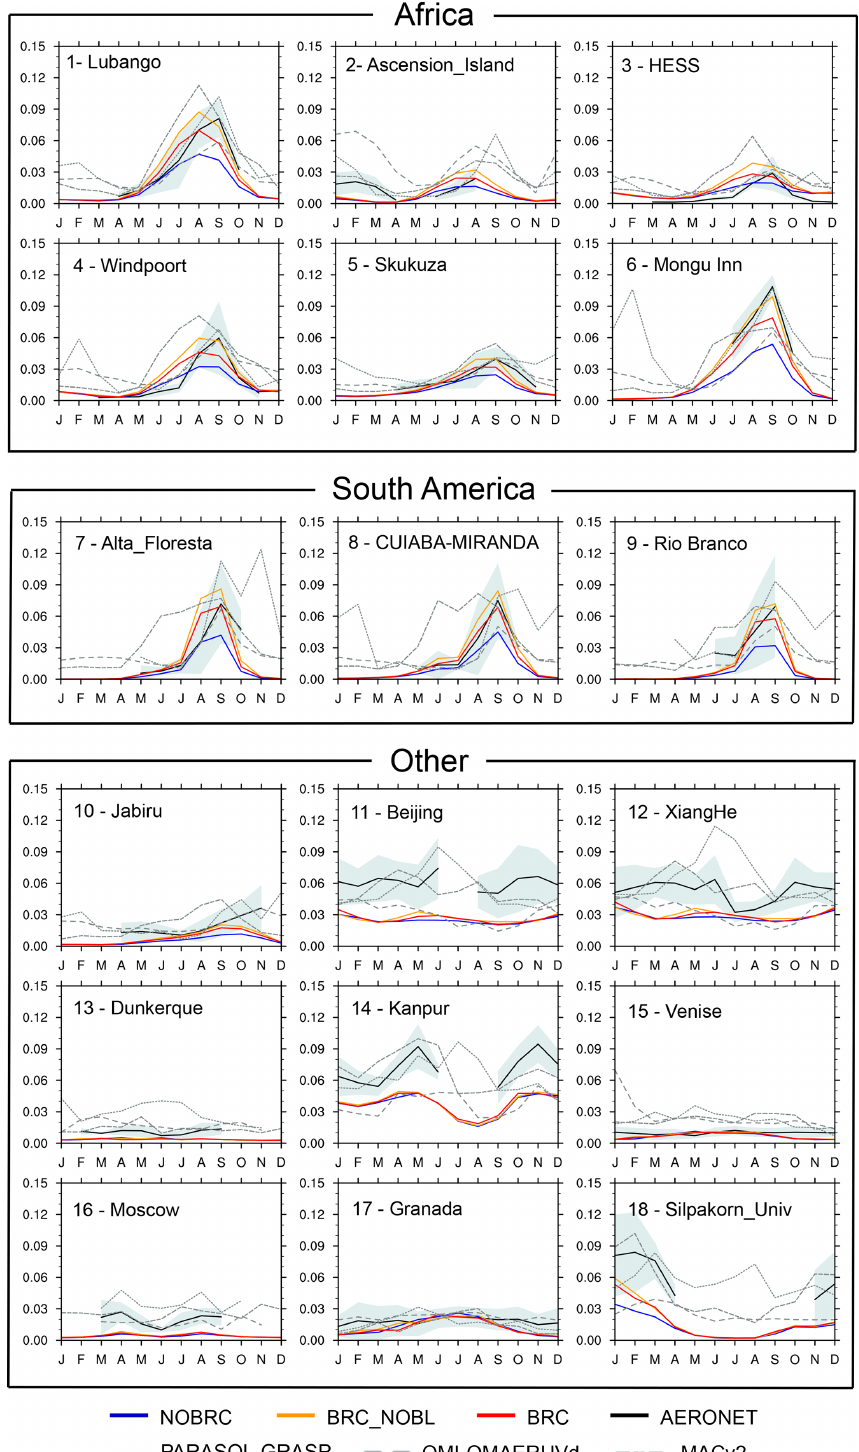
Figure 4. Same as Fig. 3 but for the AAOD (440nm; see Tables 2 and 3 for